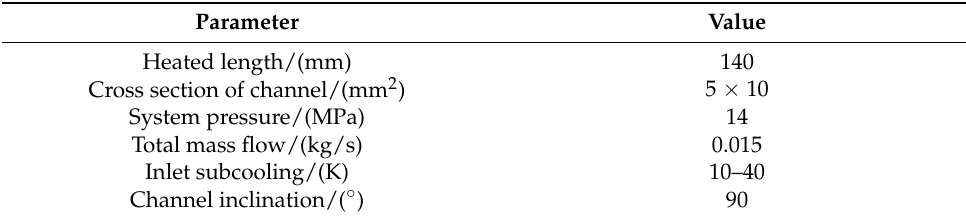
Figure 8. Constant amplitude oscillation at critical thermal power. Table 4. Parameters of fluid and